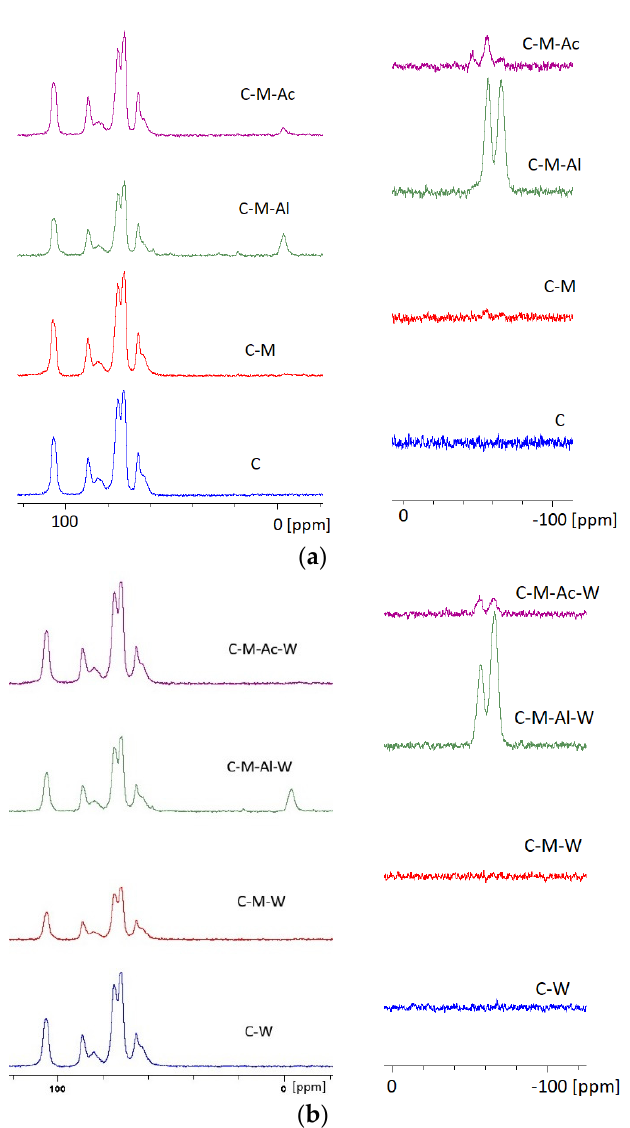
Figure 5. Spectra: ( a ) 13 C and 29 Si NMR of cellulose; ( b ) 13 C and 29 Si NMR of cellulose after leaching.